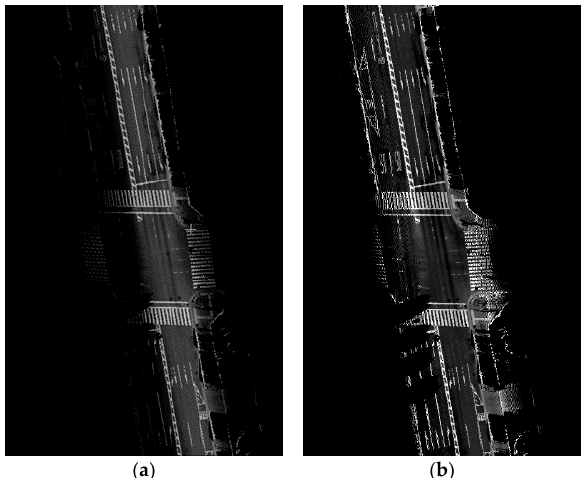
Figure 11. Intensity calibration of MMS point cloud: ( a ) original intensity of the MMS point cloud; and ( b ) calibrated intensity using the proposed method.